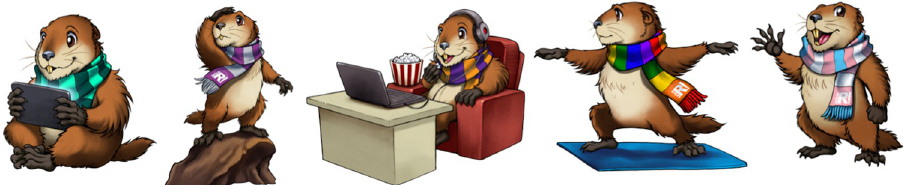
Fig 2. Margot the marmot was the useR! 2021 mascot. AU : AbbreviationlisthavebeencompiledforthoseusedinFig 2 : Pleaseverifythatallentriesarecorrect : To represent the global and inclusive nature of the conference, Margot was drawn using scarves representing the colors of diverse communities of practice that are part of the large R community and specific groups of people we wanted to support explicitly. From left to right: Margot wearing scarves with the colors of MiR (https://mircommunity.com), R-Ladies (https://rladies.org), AfricaR (https:// africa-r.org), and the LGBTQIA+ and transgender communities. Margot was created by Francisco Etchart and is available under a CC-BY-NC-SA license (https://github.com/useRconf/visuals-2021). See alt-text in the “Alternative text for figures” section. MiR, Minorities in